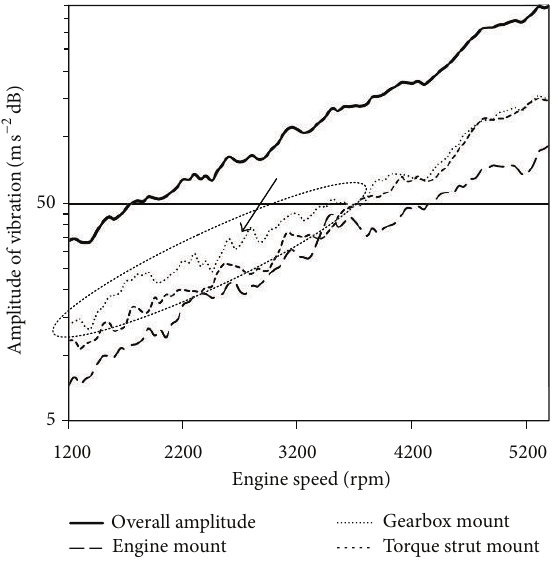
Figure 8: Dynamic mount stiffness obtained by